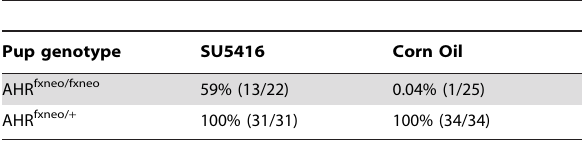
Table 1. In utero exposure to SU-5416 stimulates closure of